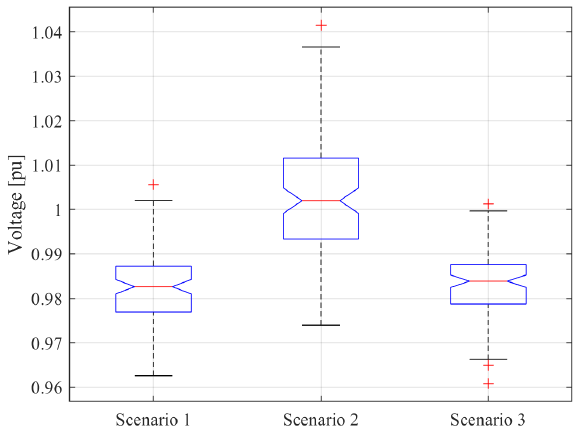
Figure 7. Voltage distribution per scenario.